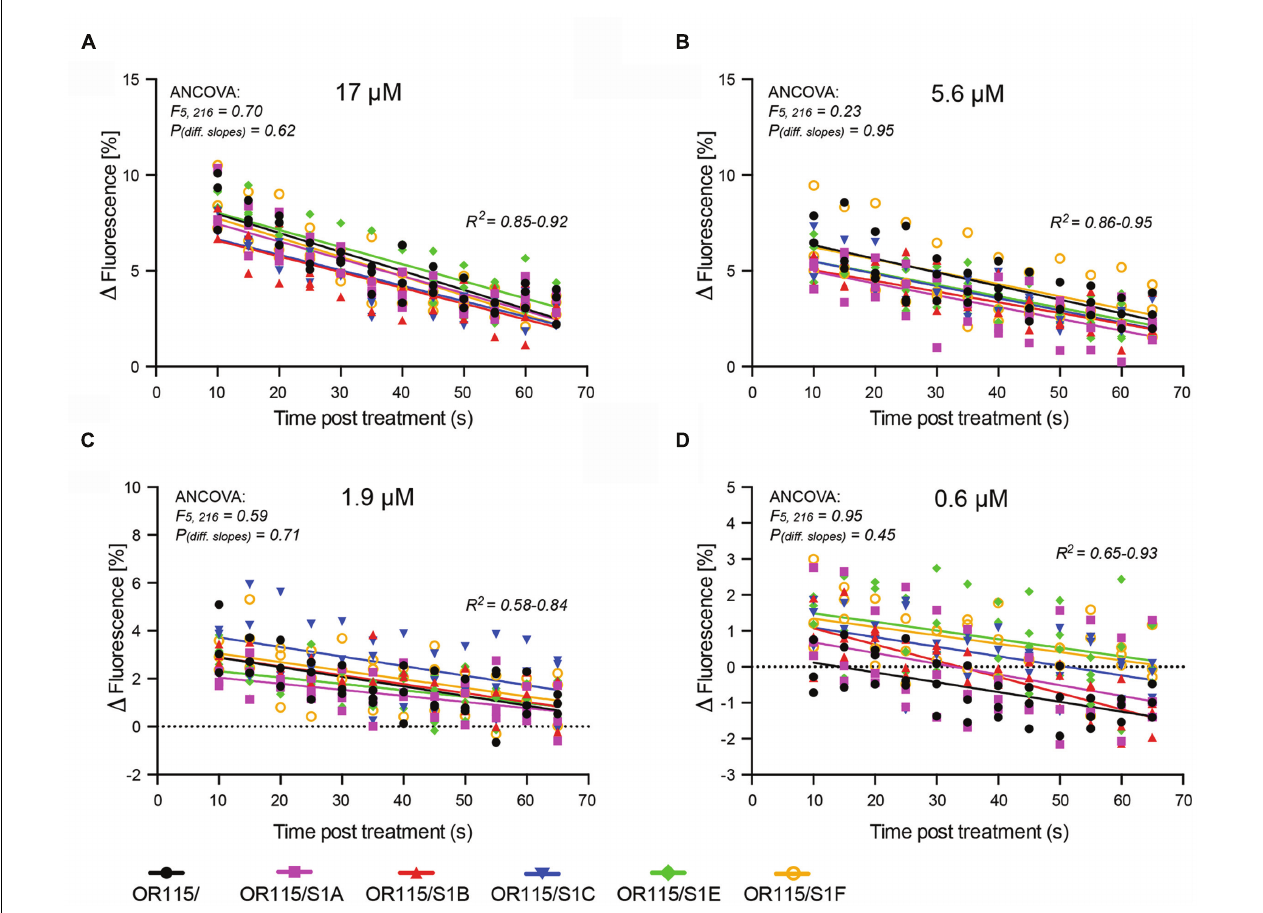
FIGURE 4 | Temporal response change post treatment of 2 S -8 E ,10 E -13:OAc in six HEK293/TMO/MdesOR115 cell lines, with or without SNMP1 (S1). (A–D) show responses to decreasing ligand concentrations. Analyses of covariance show that the slopes do not differ between different cell lines. Each data point (biological replicate) is the average of three technical replicates ( n = 3–4 biological replicates, total n =